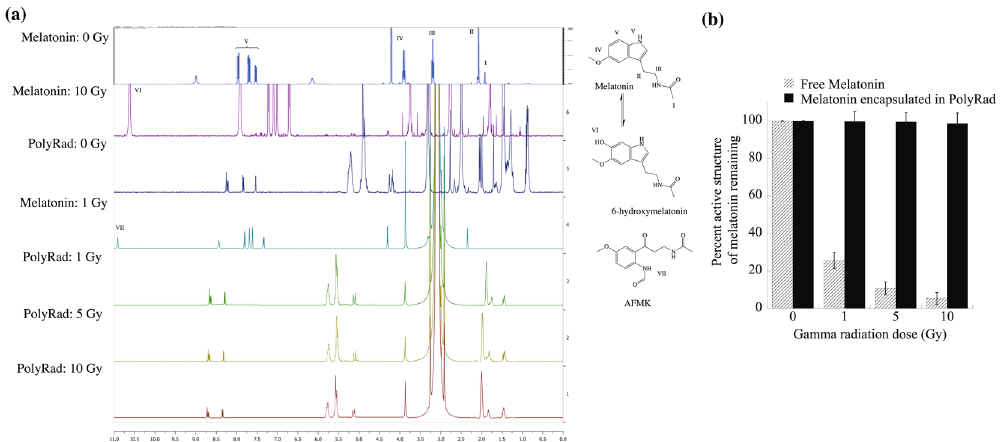
Figure 7. The effects of gamma irradiation on melatonin using 1 H-NMR spectroscopy. ( a ) Melatonin degradation was observed at 1, 5 and 10 Gy doses using a Co-60 source. The structure of melatonin alone without radiation is shown as a control. (b) The areas under the curve of 1 H NMR peaks were integrated to determine the percentage melatonin degradation. Experiments were performed at least in triplicate to estimate the mean and standard deviation of each peak area.